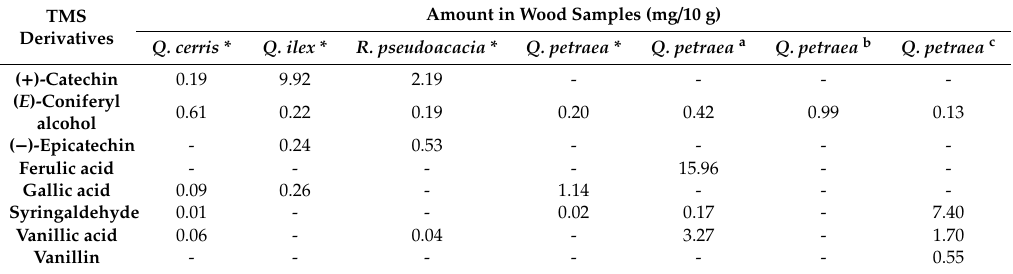
Figure 1. Profile according to NEP of ( A ) Q. petraea ; ( B ) Q. cerris ; ( C ) Q. ilex ; ( D ) R. pseudoacacia. Peak numbers identify the compounds as reported in Table 1. Table 4. TMS compound amounts (mg) calculated with respect to the extracted mass (10